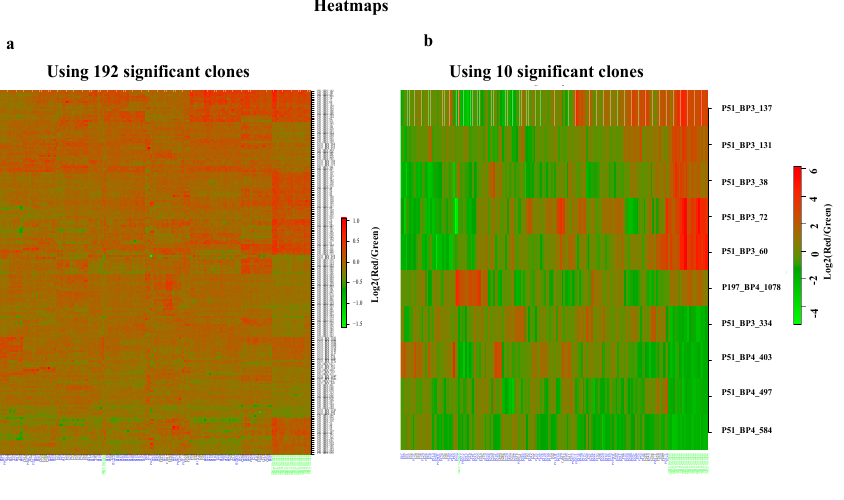
Figure 2. Heatmaps generated based on 192 clones and the 10 highly significant clones from the data of 176 study subjects (45 healthy controls, 24 with TB, and 107 with sarcoidosis) ( a , b ). Each row represents a clone, while each column represents a study subject. As shown in Figure 2, most of TB samples clustered to the right side of heatmap plots, while sarcoidosis samples and healthy controls clustered on the left side of the plot, indicating different expression profiles.